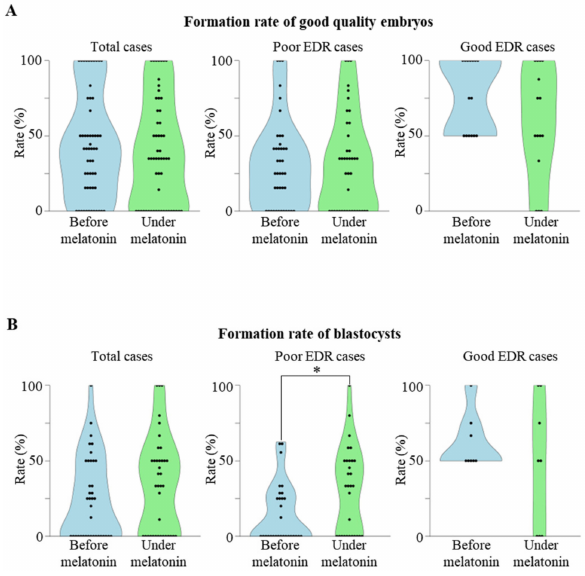
Figure 2. Association between previous embryo development rate (EDR) and the effect of melatonin. ( A ) Effect of melatonin on the formation rate of good quality embryos. The formation rates of good quality embryos in the cycles before and under melatonin treatment are shown in the violin plot. Left graph: Effect of melatonin in total 56 cases. Middle graph: Effect of melatonin in 41 cases with poor embryo development rate (EDR) (either the formation rate of good quality cleavage-stage embryos or the formation rate of blastocysts before melatonin treatment was less than 50%). Right graph: Effect of melatonin in 15 cases with good EDR. ( B ) Effect of melatonin on the formation rate of blastocysts. The formation rates of blastocysts in the cycles before and under melatonin treatment are shown in the violin plot. Left graph: Effect of melatonin in total 38 cases. Middle graph: Effect of melatonin in 30 cases with poor EDR. Right graph: Effect of melatonin in 8 cases with good EDR. * p < 0.05 vs. before